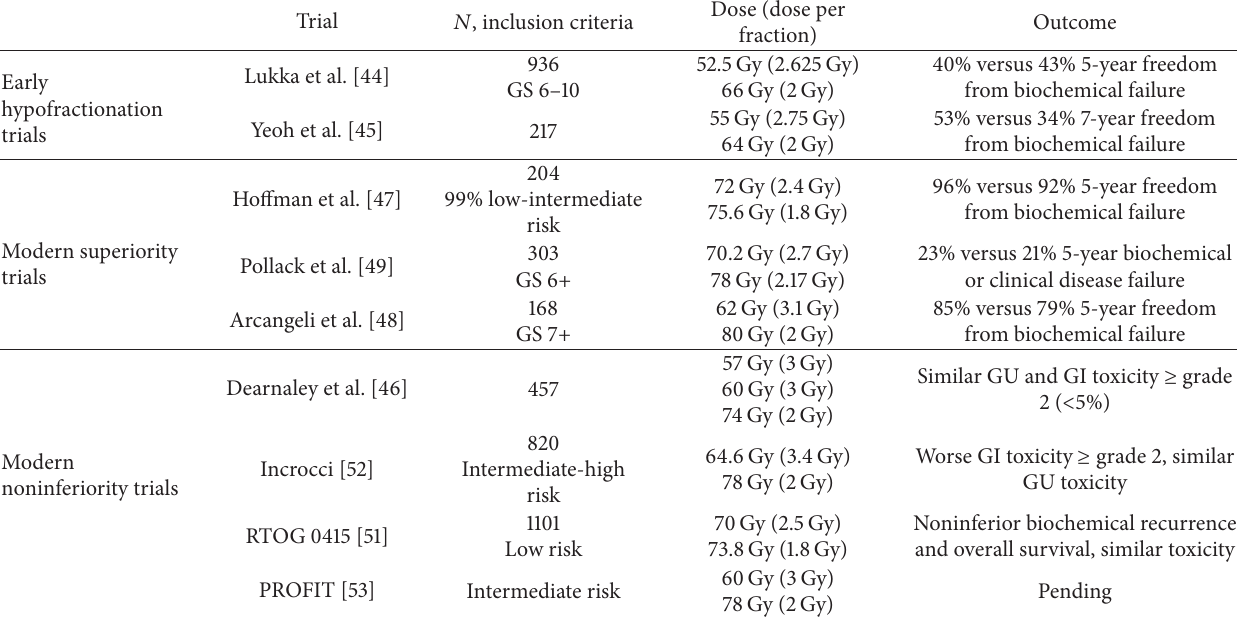
Table 2: Randomized controlled trials evaluating the efficacy and toxicity of hypofractionated radiation